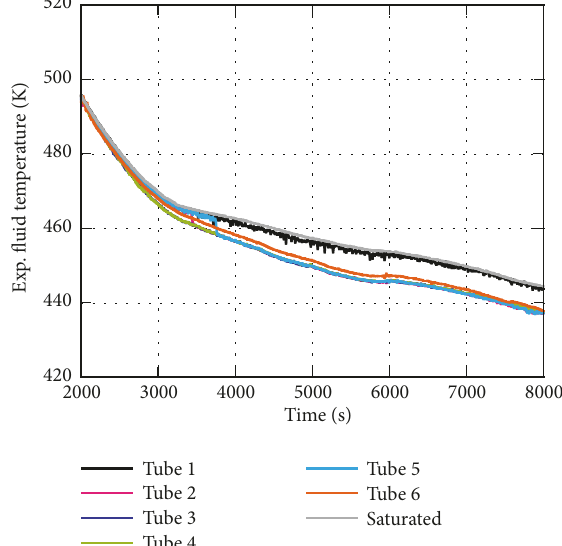
Figure 13: RELAP5 sensitivity analysis results for core collapsed liquid level and cladding surface